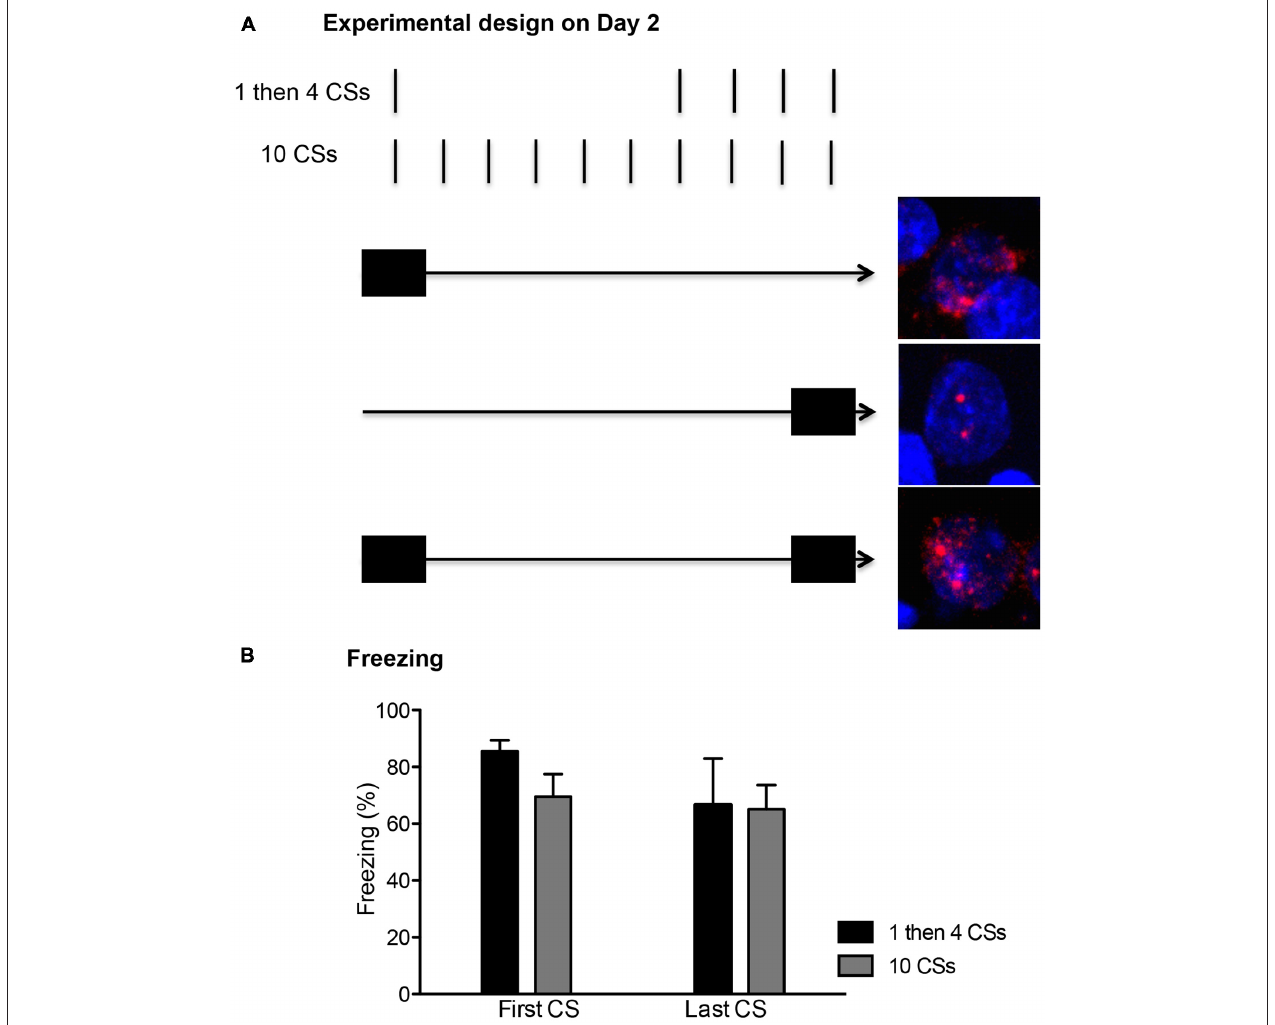
FIGURE 2 | (A) The conditioned stimulus (CS) presentations were arranged temporally to correlate with the peaks for cytoplasm and nuclear expression of Arc mRNA. The first CS presentation in both groups occurred within the first 5 min (depicted with a filled rectangle). This allowed for about 25 min wait period since the initial Arc induction, showing peak cytoplasmic expression (shown as the red perinuclear staining around the blue DAPI+ cell in the top picture). The last CS presentation in both groups occurred within the last 5 min before the rats were killed, thus matching the peak nuclear Arc expression (shown as two red foci inside of DAPI+ cell in the middle picture). A cell with Arc induction at both time points should show both nuclear and perinuclear staining as seen in the bottom picture. (B) Freezing levels were comparable between the first and last CS presentations and also between the two groups ( n = 6 for each